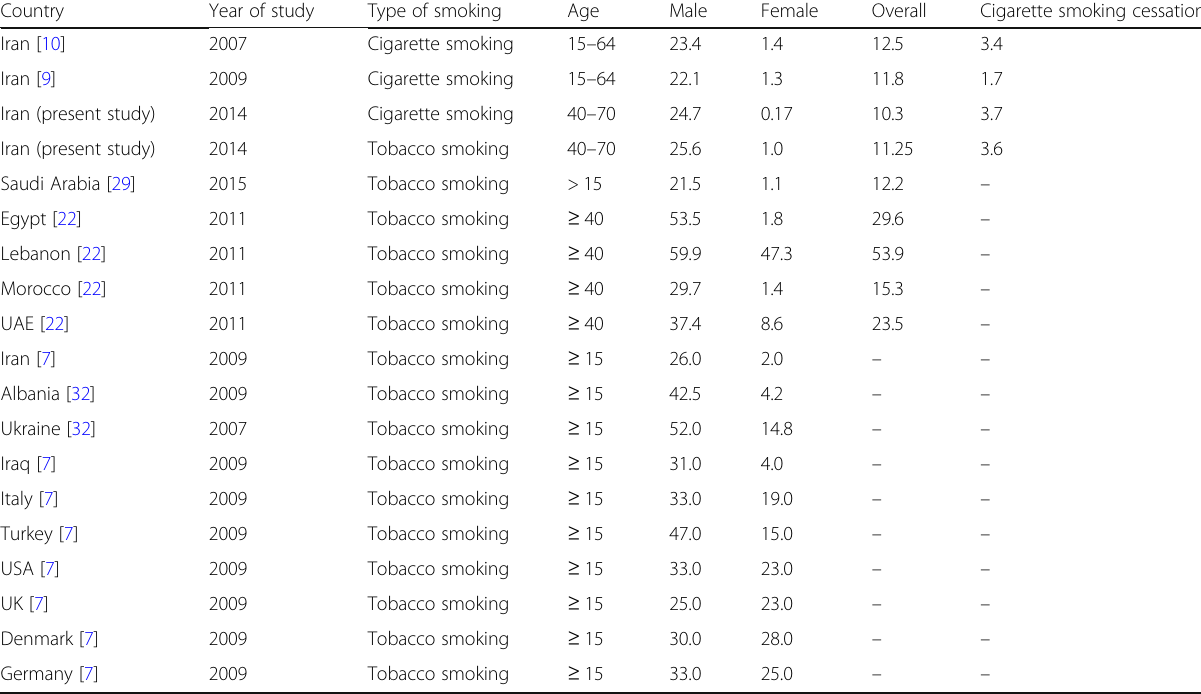
Table 3 Comparison of the prevalence of smoking in various countries